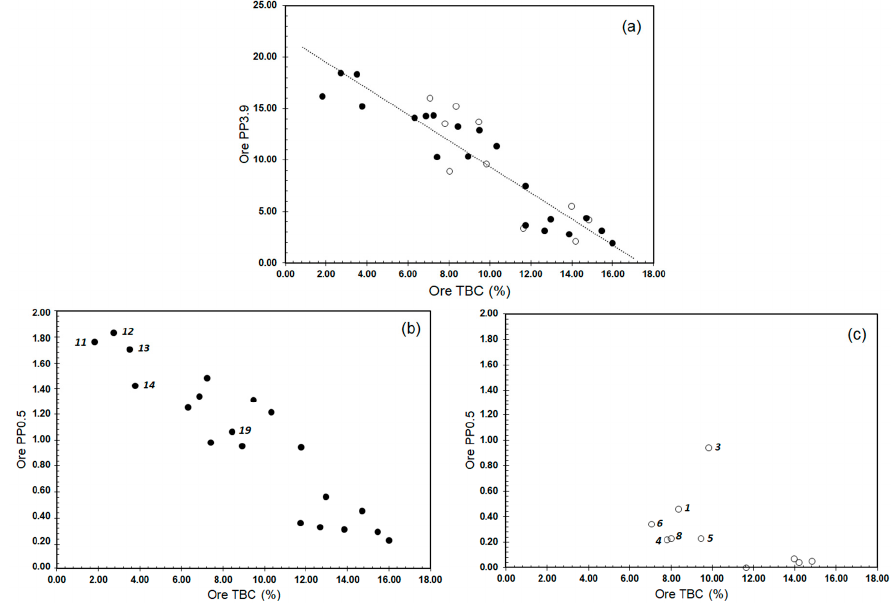
Figure 1. Variability in ore fines (pp3.9%) and ultrafines (pp0.5%) content as a function of bitumen (TBC). ( a ) pp3.9% versus TBC%. ( b ) pp0.5% versus TBC% for sample suite 1. ( c ) pp0.5% versus TBC% for sample suite 2. Open and filled circles represent sample suites 1 and 2, respectively. Numbers refer to the sample numbers listed in Table 1.